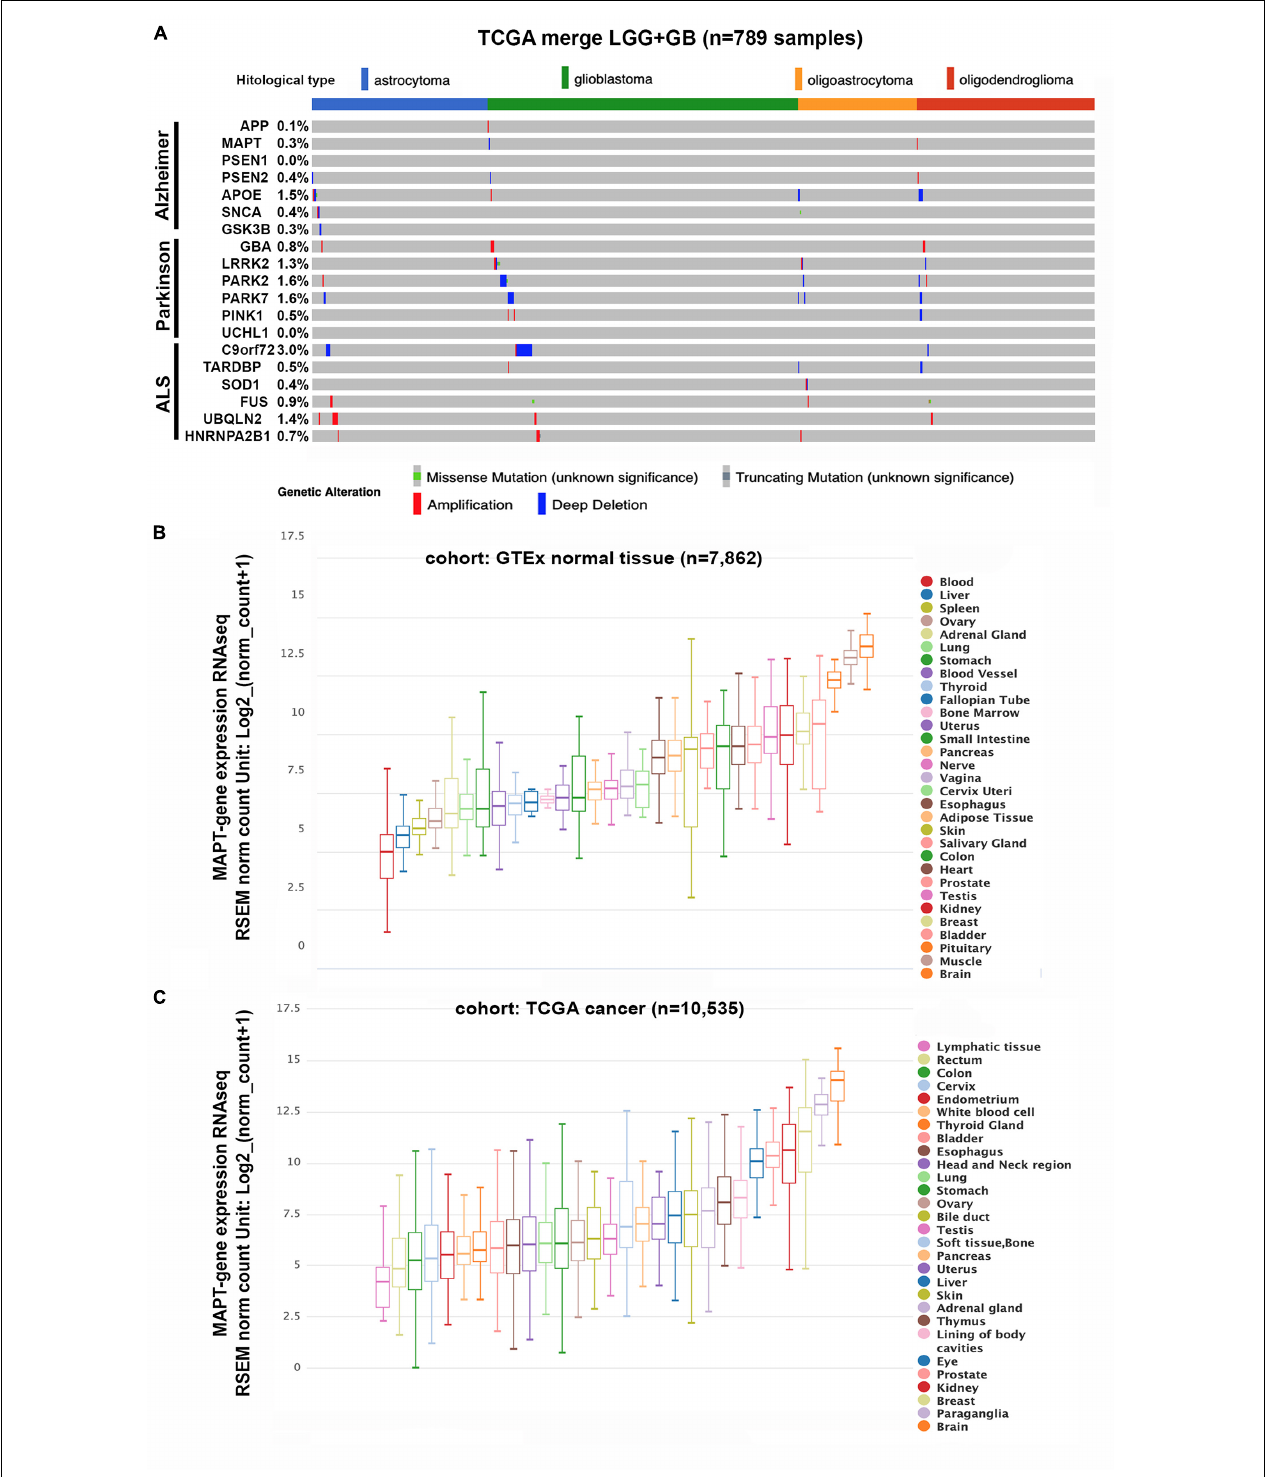
FIGURE 1 | Genetic status and gene expression of neurodegeneration-related genes in cancerous and normal tissues. (A) Histogram showing non-silent somatic mutations and copy number variations of genes commonly altered in AD, PD, and ALS on the TCGA cohort of diffuse gliomas ( n = 789), grouped according to the WHO classification (histological type). (B,C) Box plots showing Tau/MAPT relative mRNA levels in different normal tissues (B) and tumors (C) , extracted from TCGA-TARGET-GTEx cohort, with RNAseq-normalized mRNA expression data.